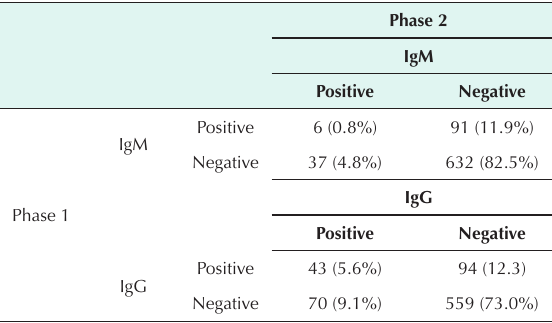
Table 4. Antibody Seroprevalence of Participants in Both